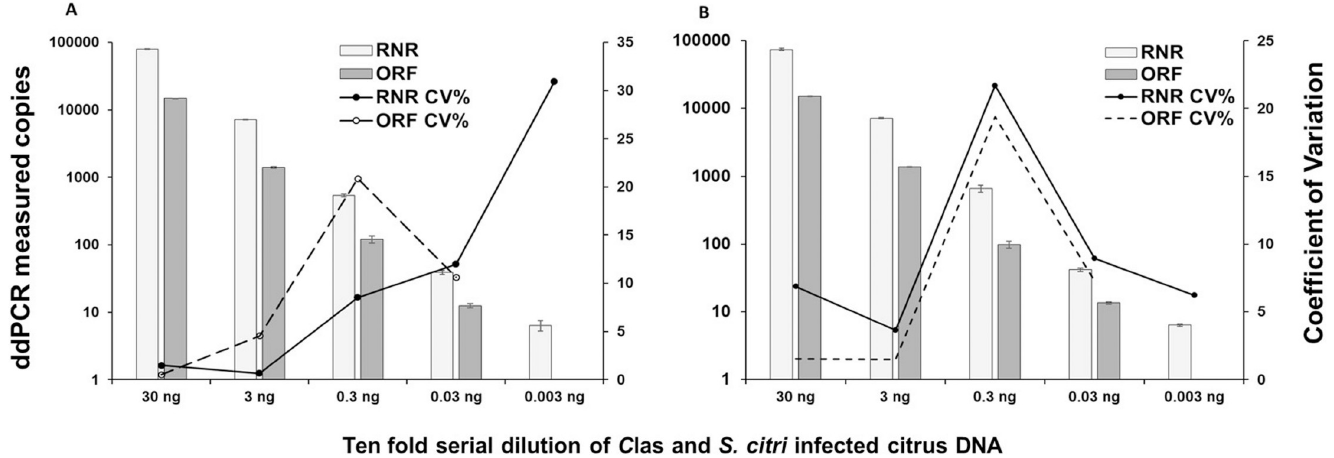
Fig 7. Intra-assay (A) and Inter-assay (B) variation of duplex ddPCR assay for detection of RNR gene of “ Candidatus Liberibacter asiaticus” and ORF1 gene of Spiroplasma citri in ten-fold dilutions of dual infected citrus leaf DNA. Bar represents the average of triplicate ddPCR values of each dilutions. CV means coefficient of variation.